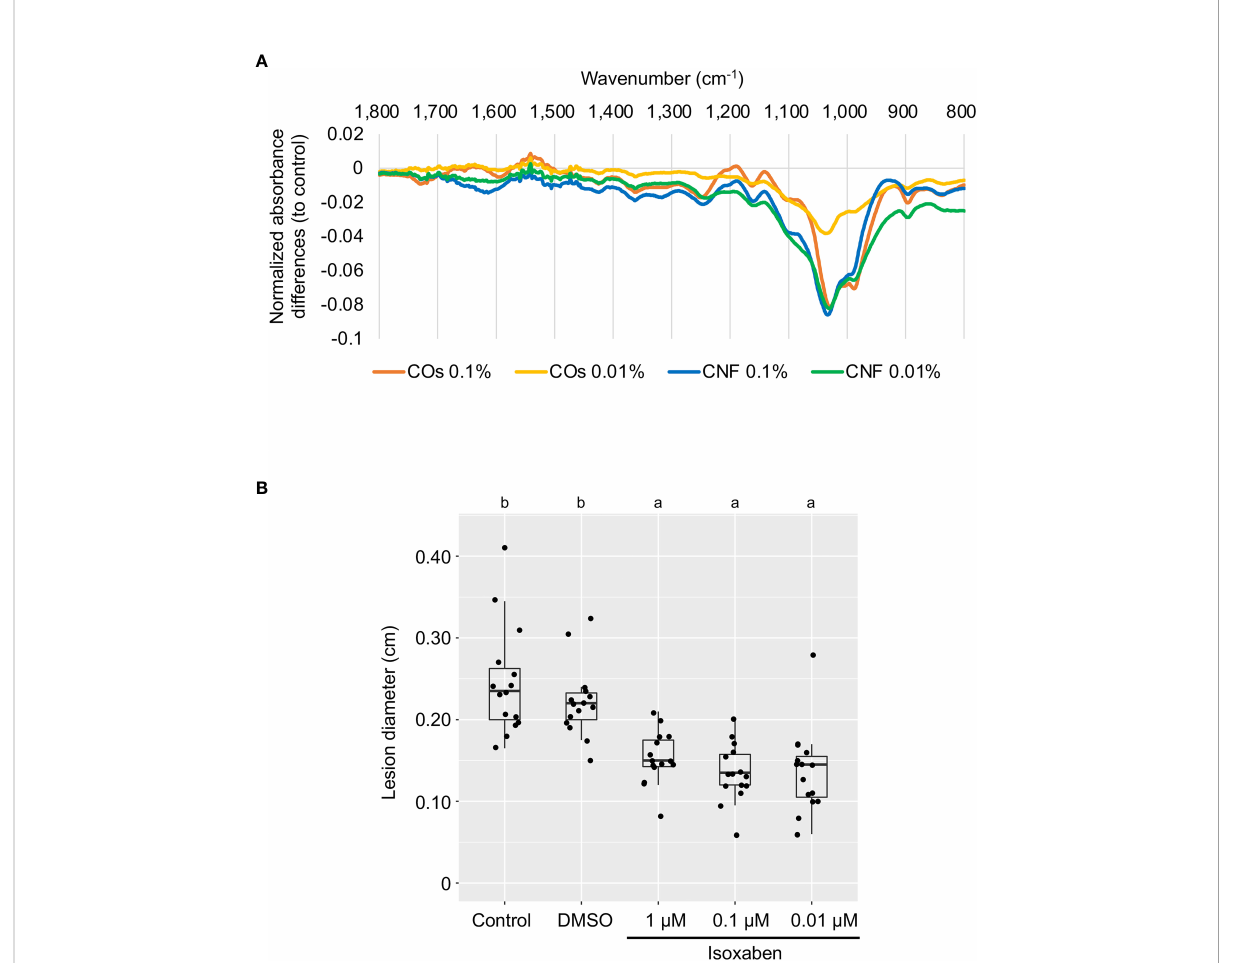
FIGURE 3 Perturbation of cell-wall biogenesis upon chitin treatments and induced systemic disease resistance in rice leaves. (A) Supplementation of soils with chitins systematically induced alterations of cell-wall composition in rice leaves. Each line represents the differential Fourier-transform infrared (FT-IR) spectra between control plants and seedlings grown on COs- or CNF-containing soils ( n = 3). (B) A cellulose biosynthesis inhibitor induces disease resistance in rice leaves. The leaves of 3-week-old rice seedlings grown on soil were sprayed with control (DW), DMSO, or isoxaben (1, 0.1, and 0.01 µM, respectively) fi ve hours before B oryzae inoculation. Lesion diameter (cm) of leaves two days after inoculation are shown. Representative results from three independent experiments are shown. Different letters indicate signi fi cant differences by Tukey ’ s test ( p < 0.05, n >